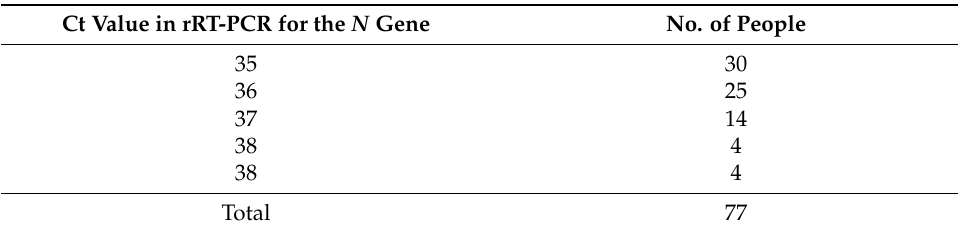
Table 1. Cumulative results of rRT-PCR for N gene in samples from people ( n = 77), who were subsequently enrolled into the study.